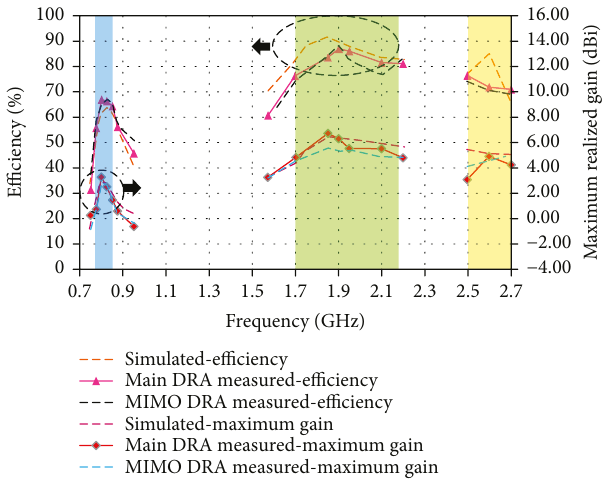
Figure 19: Measured and simulated maximum realized gains and total e ffi ciencies of the MIMO system.